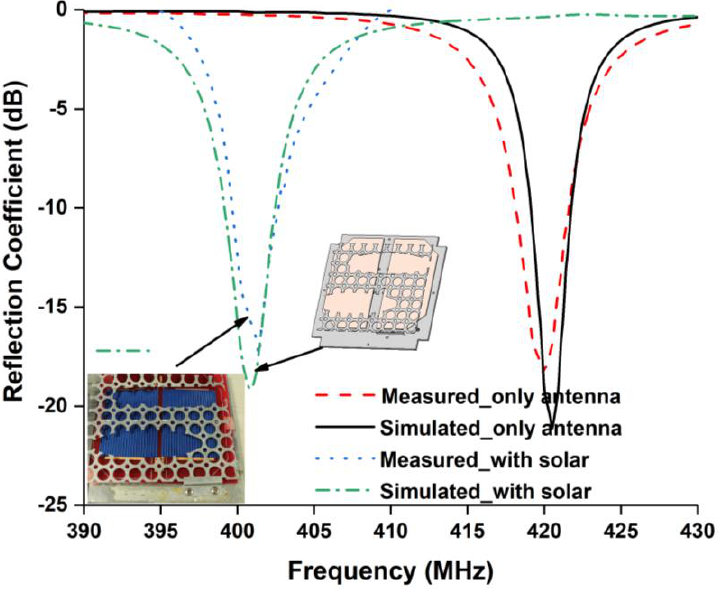
Figure 2. Reflection coefficient of the proposed